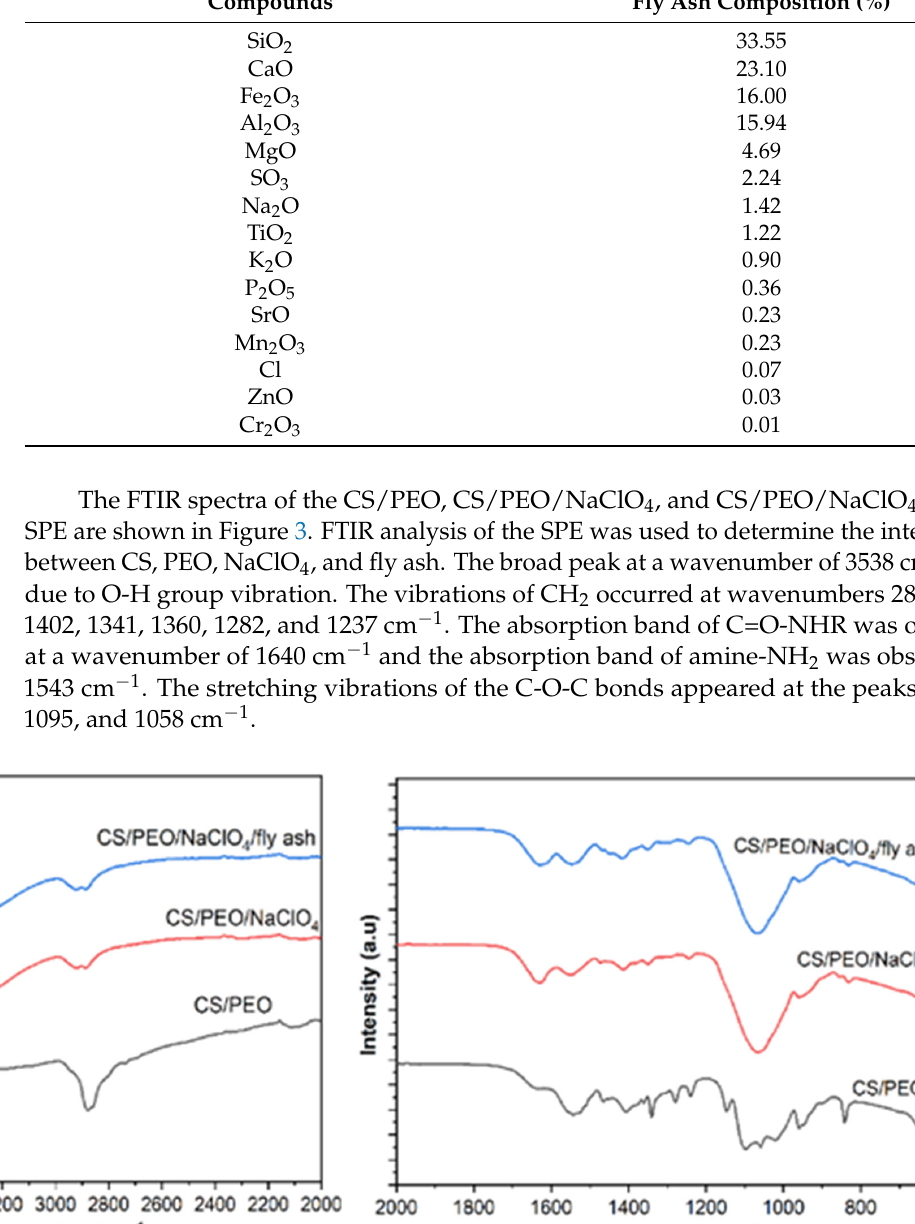
Table 2. Fly ash composition from PT. Paiton.